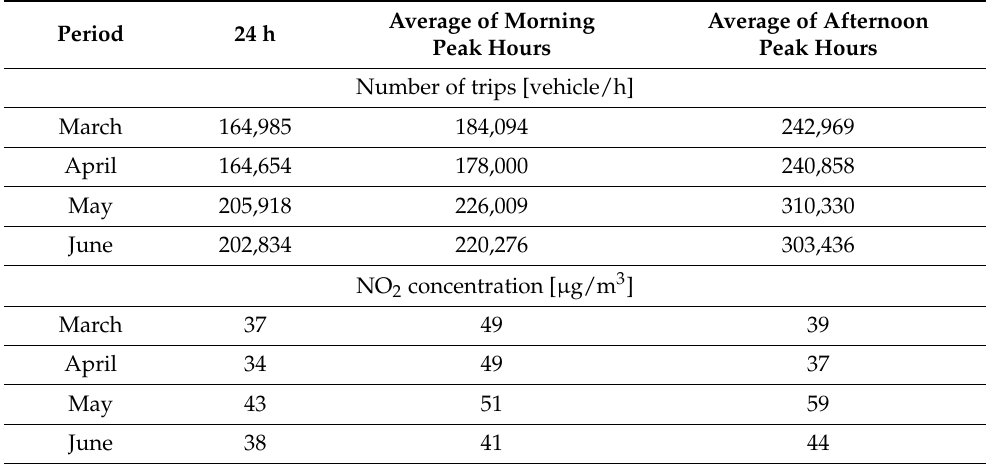
Table 3. Number of trips generated and NO 2 concentration averaged over the 2020 peak hour (working